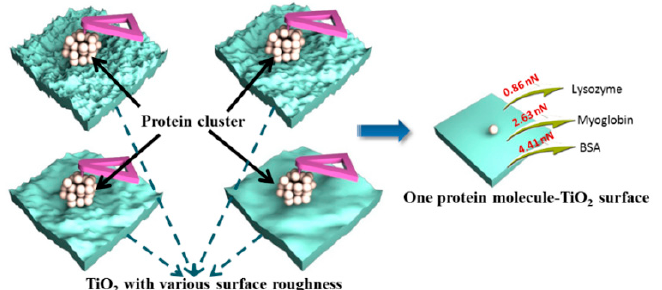
Figure 4. The molecular interaction of different proteins with TiO 2 with different surface roughness decomposed from the total adhesion force. Reprinted from Ref. [85] with permission from the American Chemistry Society.